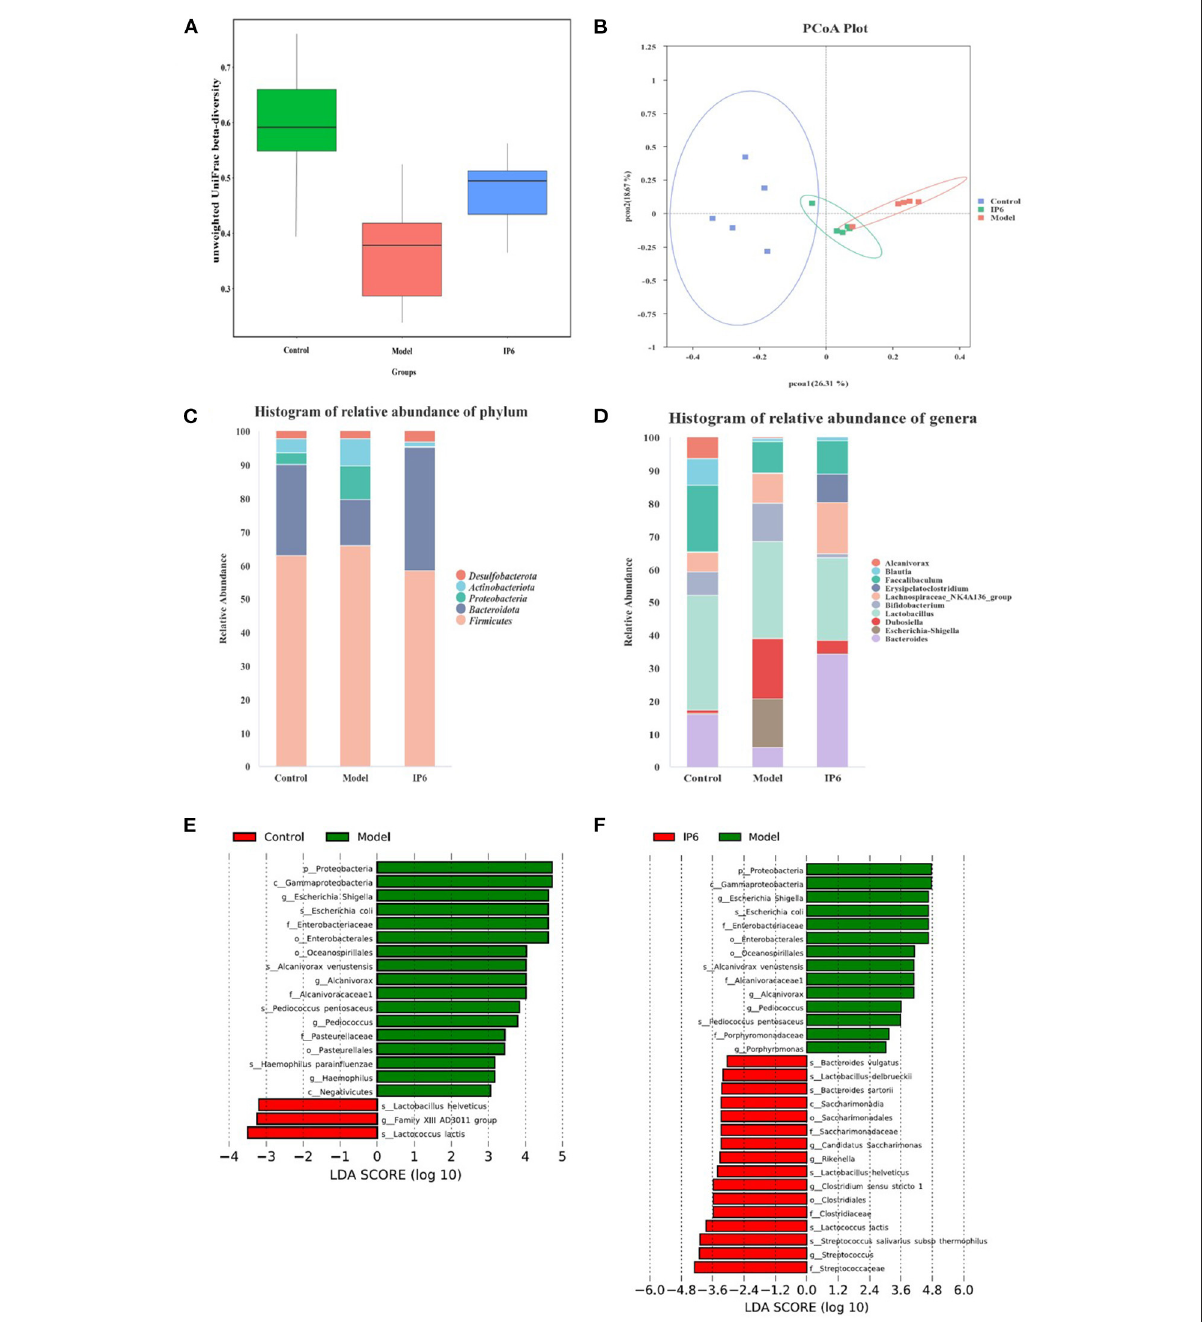
FIGURE2 IP6 administration changes the composition of the gut microbiota in model mice. (A) Beta diversity of unweighted UniFrac distances analysis in gut microbiota. (B) The principal coordinates analysis (PCoA) of the unweighted UniFrac distances analysis. (C) Histogram of relative abundance of Top5 at the phylum level. (D) Histogram of relative abundance of Top10 at the genera level. (E) LDA scores of differentially abundant taxa between the Control and Model mice using the LEfSe method. (F) LDA scores of differentially abundant taxa between the Model and IP6 mice using the LEfSe